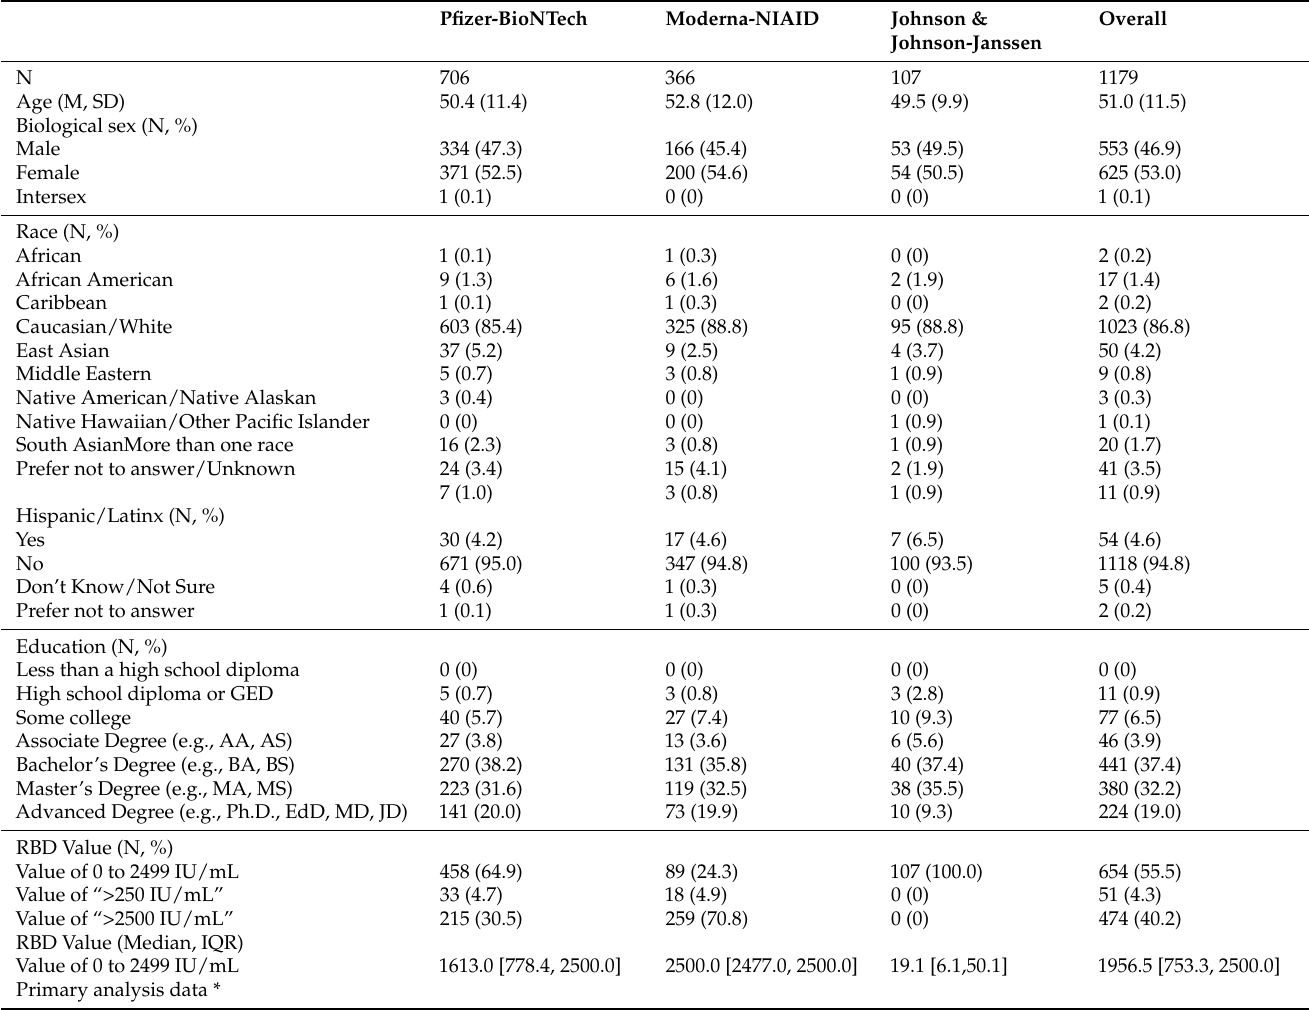
Figure 1. Participant flow through the study. Table 1. Participant